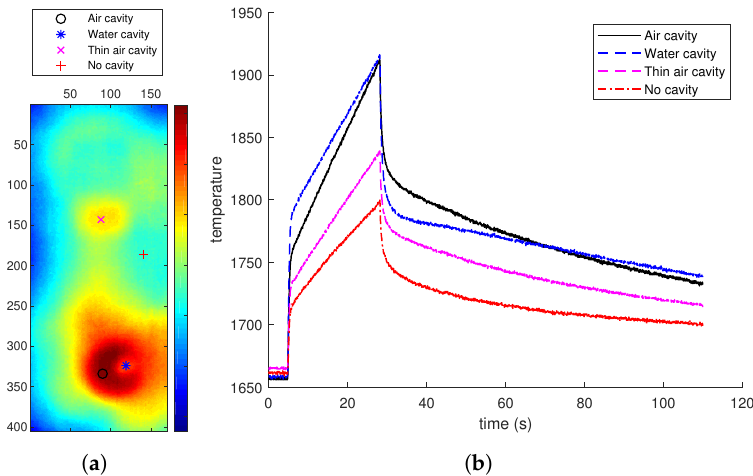
Figure 11. Temperature comparison; experiment 2. ( a ) Selected points. ( b ) Temperature-time graph for non-cavity regions vs. different cavities.